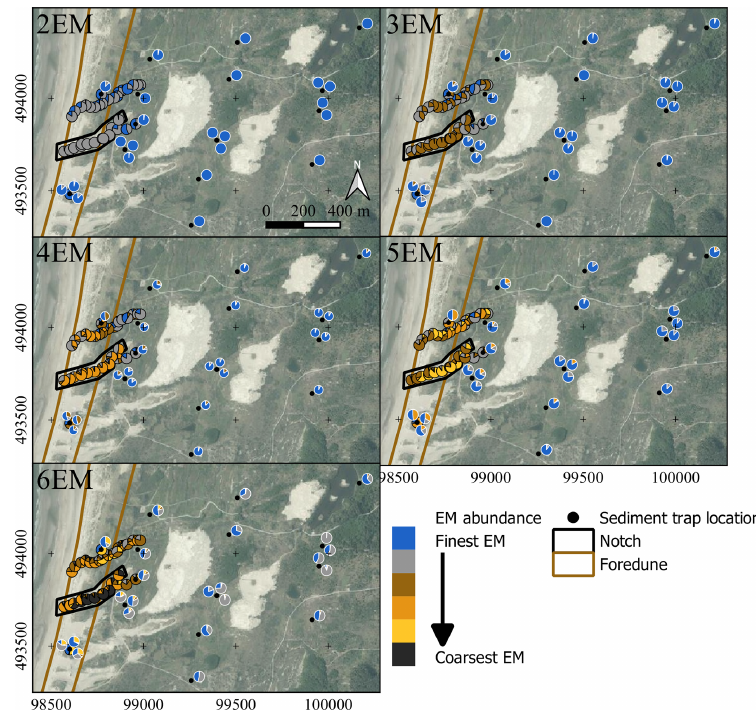
Figure A11. Endmember abundances for variable ConD2d determined for the dune dataset. Pie charts with a black outline denote surface samples and are plotted at the sampling location. Pie charts with a white outline denote sediment-trap samples and are plotted near the sampling location. The exact locations of sediment traps are marked by black dots. Two of the subregions defined in Fig. 1c are shown in simplified form. Aerial photograph © PDOK.nl,